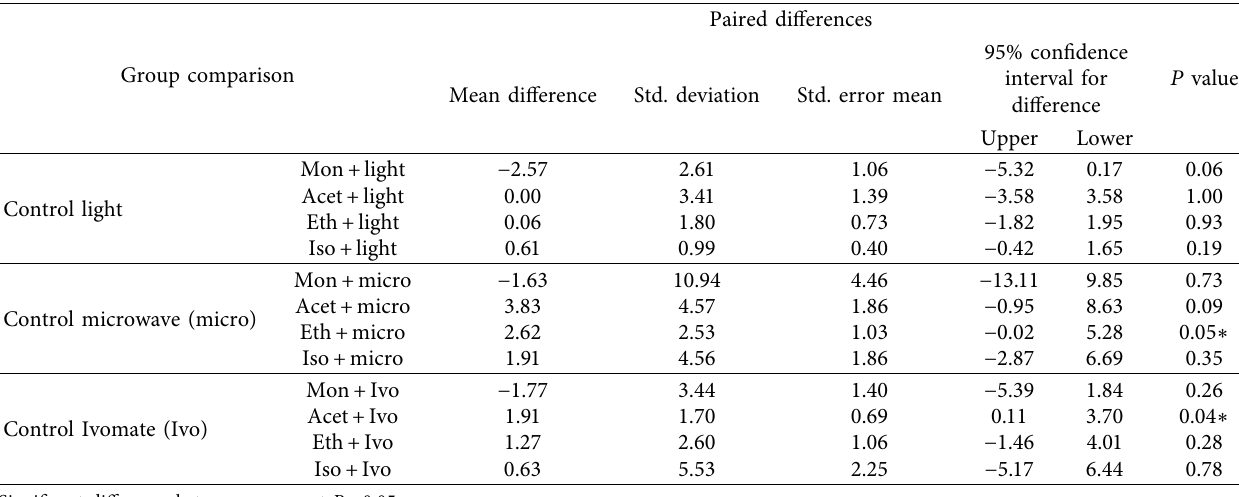
Table 3: Multiple comparison test for the control (non-surface treated) samples with other surface-treated samples using ANOVA with Sidak’s test.